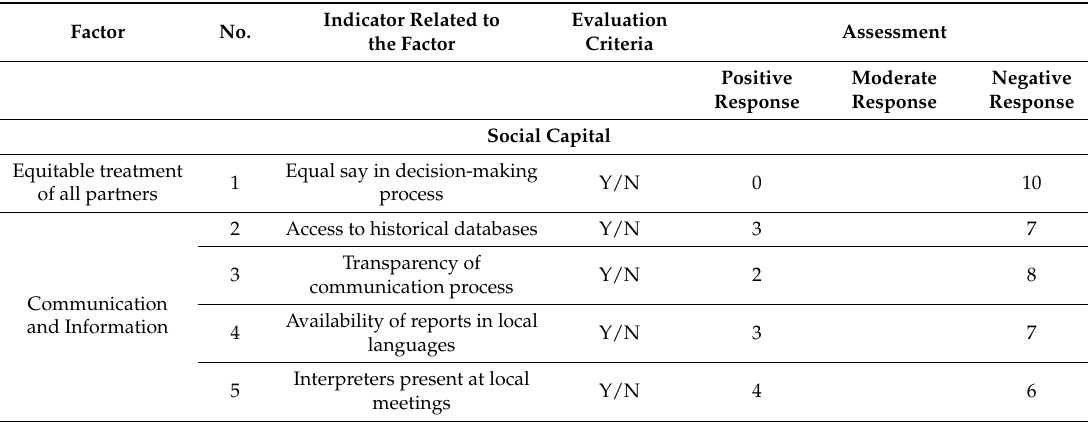
Table A1. Detailed responses to each indicator, factor and